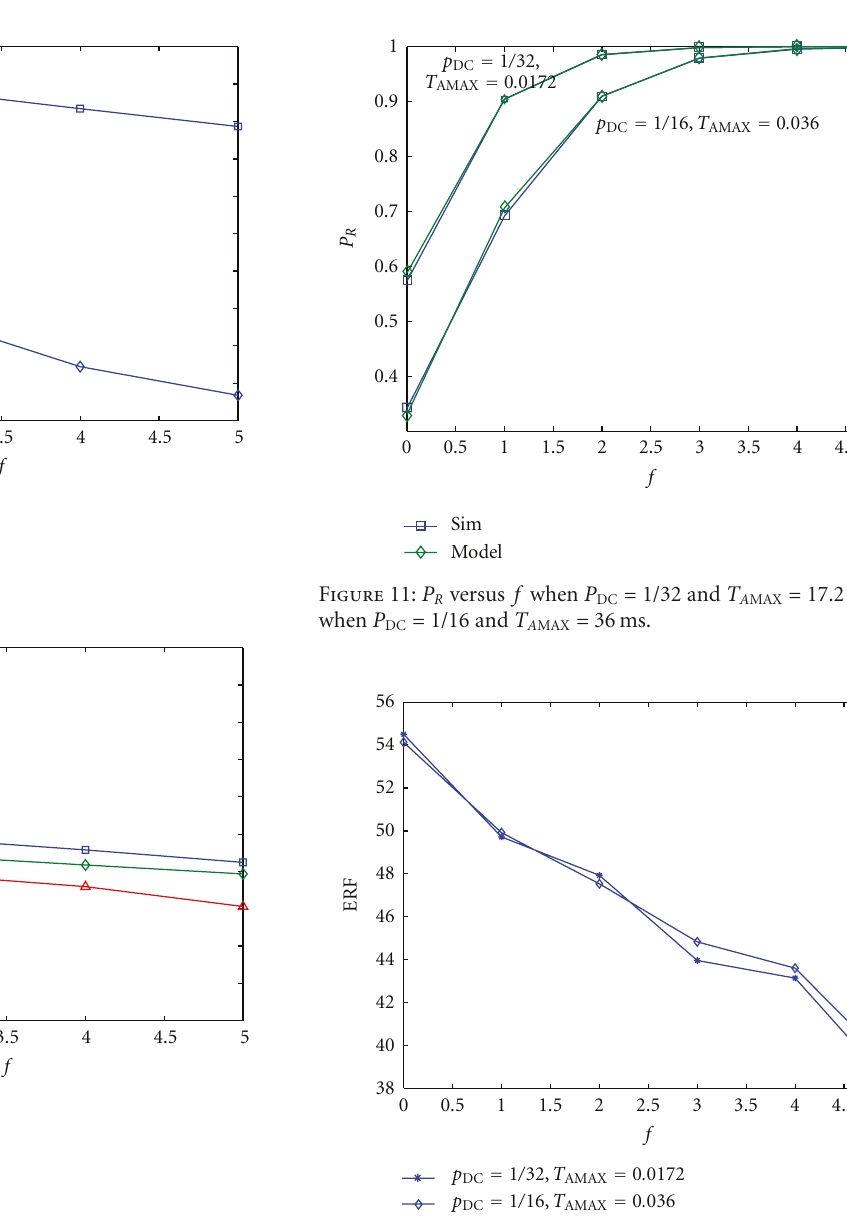
Figure 12: ERF versus f when P DC = 1/32 and T A MAX = 17.2 ms, and when P DC = 1/16 and T A MAX = 36